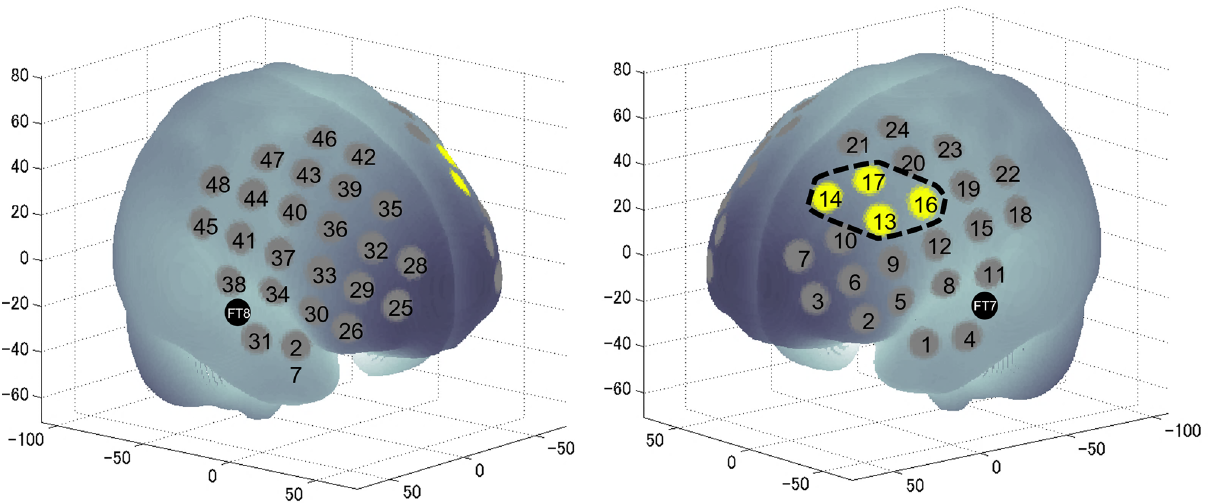
Figure 3. The spatial profiles of functional near-infrared spectroscopy channels and region of interest segmentation used in the current study; they were introduced in previous studies 46,50 . Channel numbers and FT7 and FT8 in the international 10–20 electroencephalography standard positions are denoted above the corresponding locations. The channels enclosed by the black broken lines were defined as the l-DLPFC, and their data were integrated for further analyses.